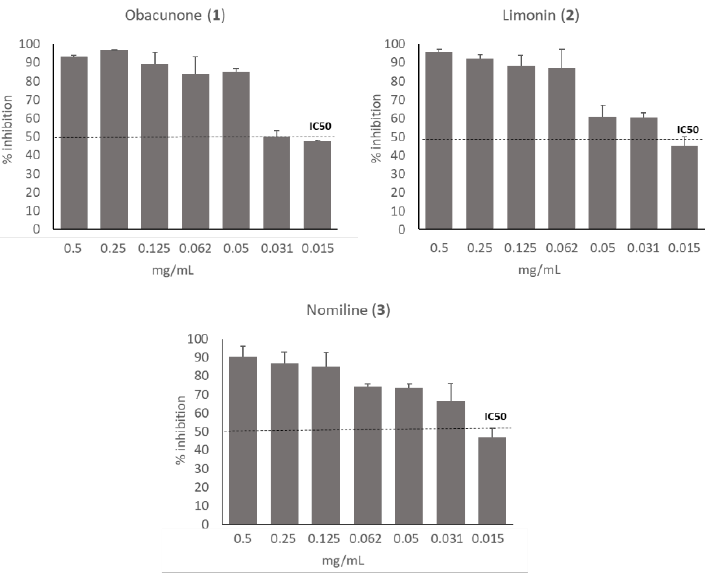
Figure 4. Dose-dependent inactivation of SARS-CoV-2 by obacunone ( 1 ), limonin ( 2 ), nomilin ( 3 ). Virucidal activity was assessed by calculating the rate of viral inhibition by PRNT on Vero E6 cells after ~16 h of contact of the substances with the virus. Half-maximal inhibitory concentration threshold, IC 50 , is shown.